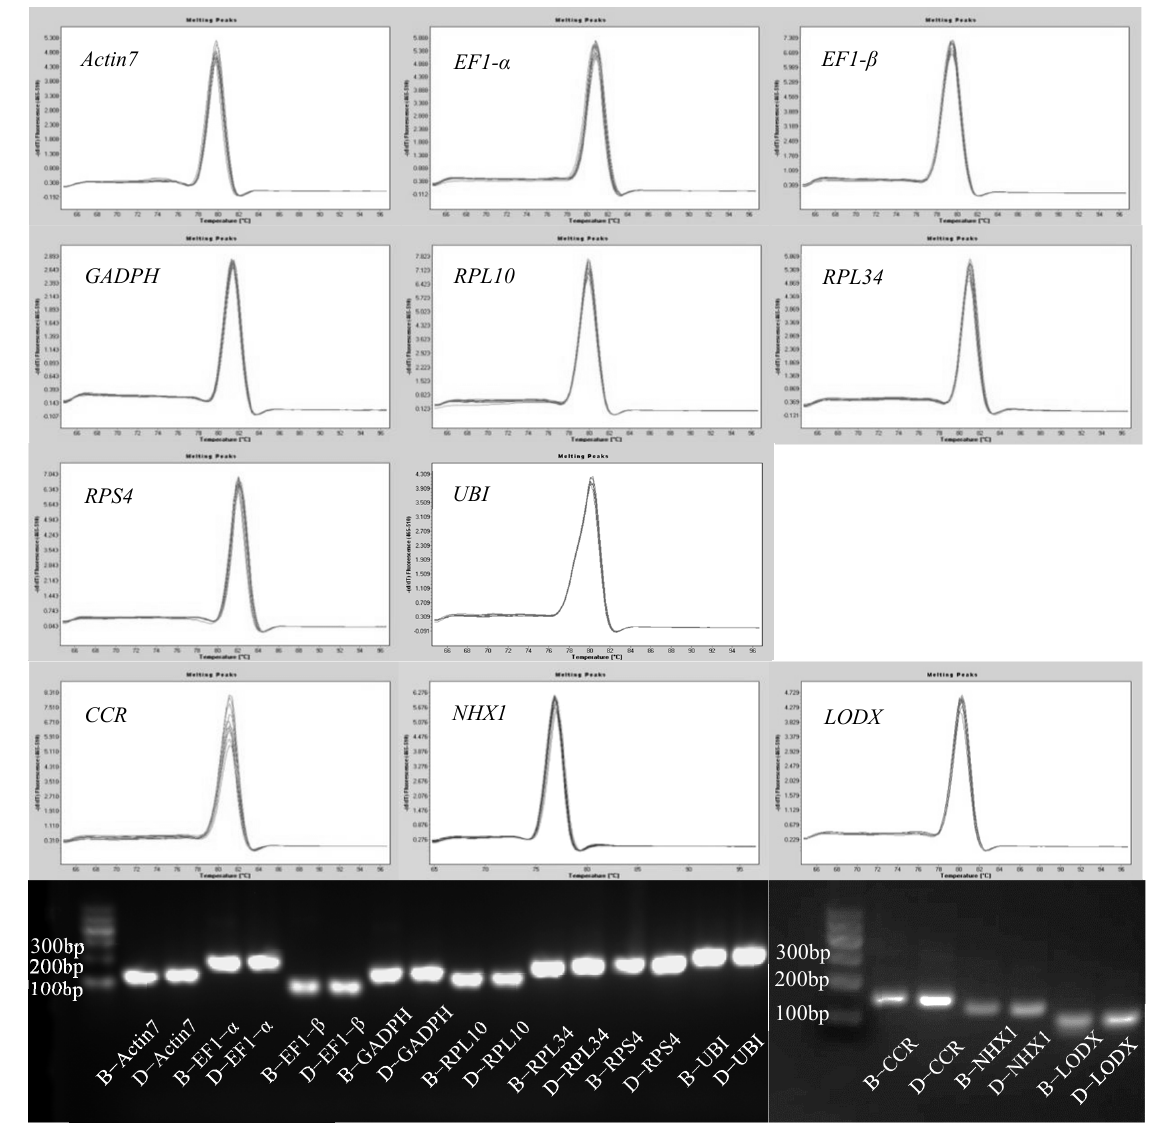
Figure 2. Melt curve and gel electrophoresis of each gene.